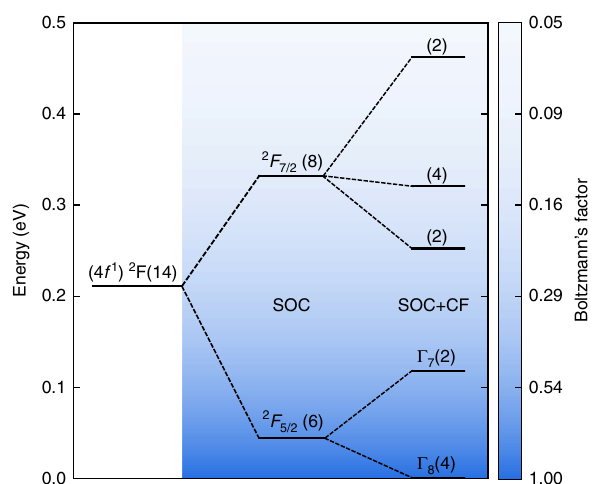
Fig. 1 Energy levels of the 4 f 1 orbital of Ce 3+ . Ce 3+ splits initially by spin- orbit coupling (SOC) and subsequently by cubic crystal fi eld (CF) of the the fl uorite structure. The spin-orbit splitting between J = 5/2 and J = 7/2 is about 0.28 eV 29, 49 . The color gradient (see color bar ) indicates the probability distribution at 1900 K, given by exp( − E i /k B T ), and numbers in parentheses stand for the degeneracy of the electronic states. The fi rst predicted Γ 8 → Γ 7 excitation for CeO 2 is 0.12 eV. Predictions for the higher CF levels of J = 7/2 are 0.25, 0.32, 0.46 respectively